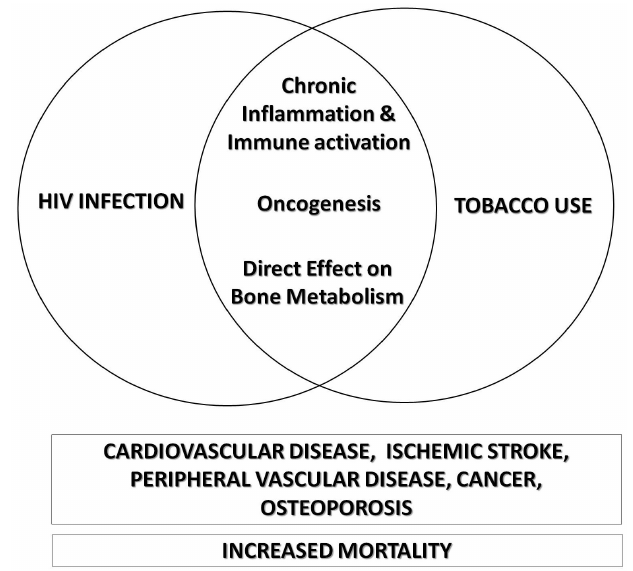
Figure 1. Through shared pathogenic mechanisms, tobacco use magnifies the independent association of HIV infection with cardiovascular disease, ischemic stroke, peripheral vascular disease, cancer, osteoporosis, and increased